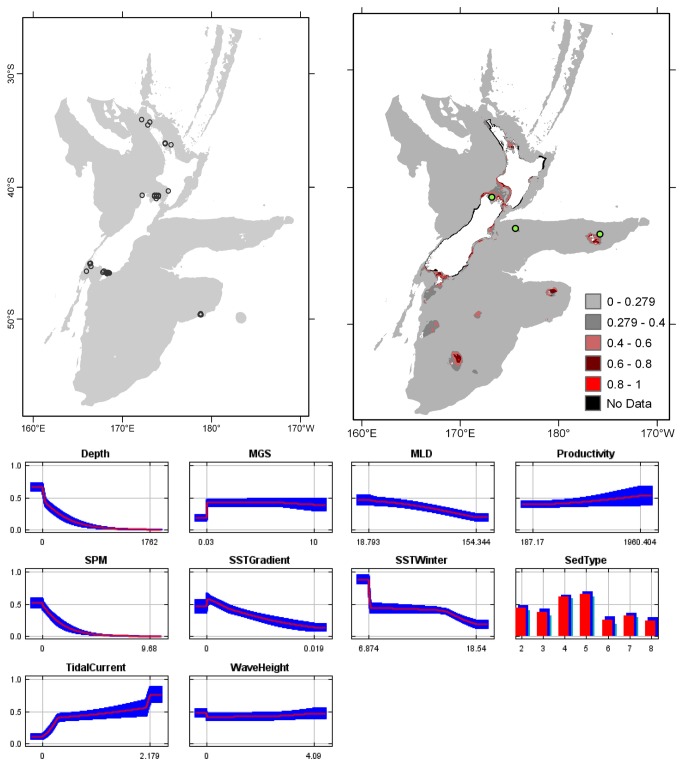

Galeopsis

porcellanicus
 known distribution (left), predicted suitable habitat (right), and fitted responses curves (marginal).For the predicted distribution, logistic probabilities less than the 10th percentile presence value indicated cells were unsuitable habitat. Probabilities of 0.4–0.6 indicated habitat suitability typical of the presence records, values of 0.6–0.8 and 0.8–1 indicated favourable and highly suitable habitat, respectively. Black cells had missing data in one or more environmental layer. Independent records are layed over the predictions. Marginal response curves show how the prediction changes for different values of each variable when all other variables were at their average sample value. Individual response curves are shown in Figure S3. For the categorical variable Sediment type: 1 = deep ocean clays; 2 = calcareous gravel; 3 = volcanic; 4 = calcareous mud; 5 = gravel; 6 = mud; 7 = sand; 8 = calcareous sand.